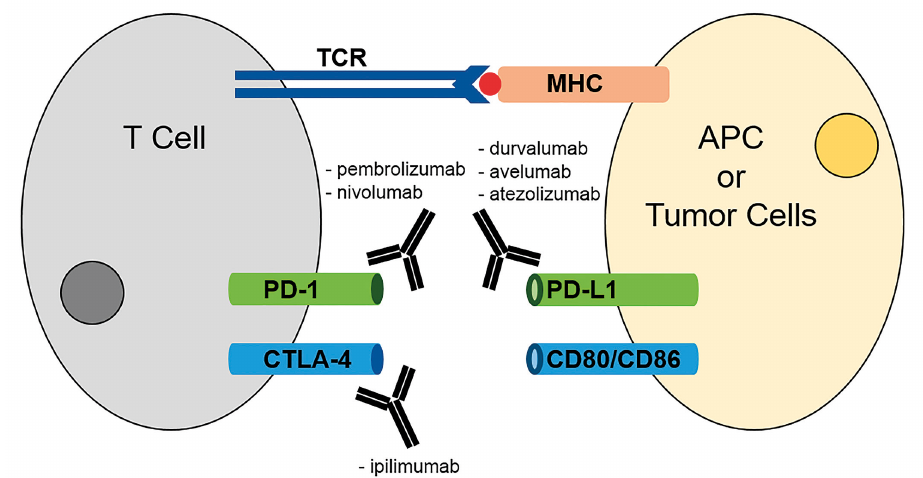
FIGURE 5 – MAbs targeting immune checkpoints. The recognition of tumor cells by antigen presenting cells (APCs) leads to T cell activation by MHC-antigen interactions with T-cell receptors. CTLA-4 and PD-1 are co-inhibitory checkpoint receptors expressed on activated T-cells which downregulate immune response. The binding of CTLA-4 to its ligands CD80/CD86 on APCs and the interaction PD-1/PD-L1 on tumor cells result in inhibition of T-cell antitumor response. MAbs targeting CTLA-4 (ipilimumab), PD-1 (pembrolizumab and nivolumab) and PD-L1(durvalumab, avelumab and atezolizumab) block these immunoinhibitory interactions thus enhancing antitumor